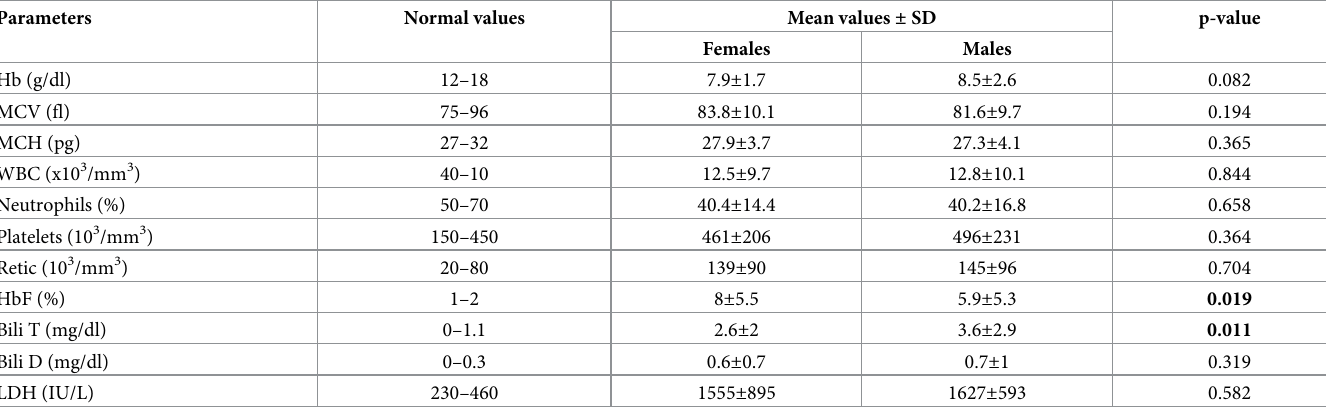
Table 4. Summary of the biological parameters.